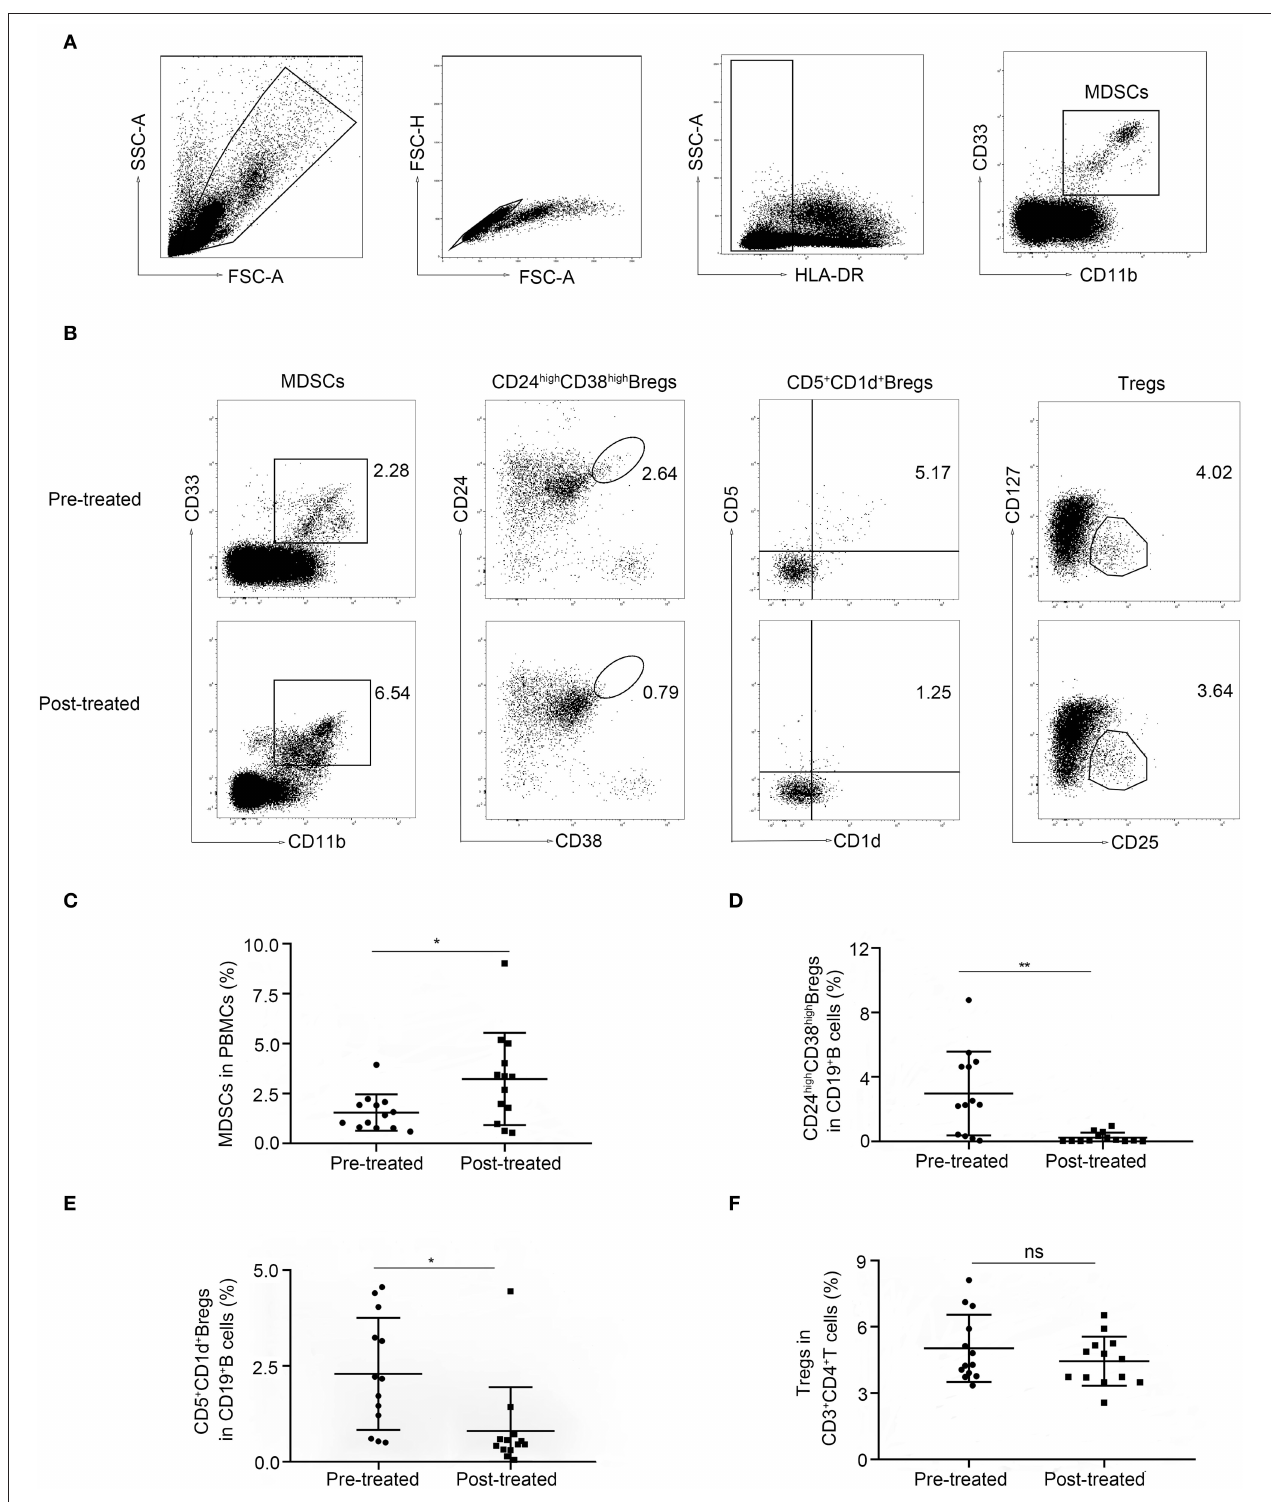
FIGURE 1 | Alternation of immune regulatory cells after immunotherapy. (A) Sequential gating strategy for myeloid-derived suppressor cells (MDSCs) identification (HLA-DR − / low CD33 + CD11b + ) from peripheral blood mononuclear cell (PBMCs). (B) Representative data plots of MDSCs, Bregs, and Tregs from patients with MG before (Pre-treated) and after immunotherapy (post-treated). The frequency of MDSCs in PBMCs increased (C) , the frequencies of CD19 + CD24 high CD38 high Bregs (D) and CD19 + CD5 + CD1d + Bregs (E) in CD19 + B-cells decreased, while the frequency of CD4 + CD25 + CD27 low Tregs in CD3 + CD4 + T-cells (F) showed no significant change. Horizontal lines and error bars represent mean ± SD, n = 13, * p < 0.05, ** p < 0.01.